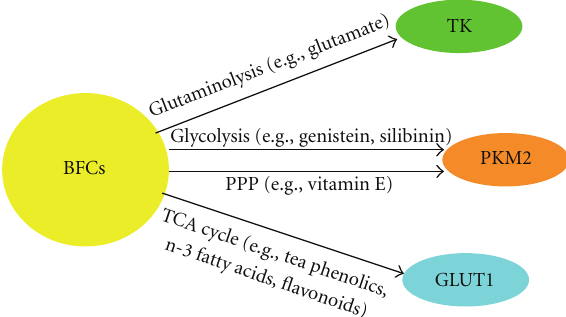
Figure 1: Potential metabonomic targets for bioactive food com- ponents during glucose metabolism in cancer cells. Cancer cells metabolize glucose and glutamine more than normal cells to sup- port the de novo biosynthesis of nucleotides and energy required for the high rate of cell proliferation. Tumor-specific PKM2 determines the ratio of glucose metabolism between glycolysis and PPP, whereas GLUT1 and TK play critical roles in energy production in neoplastic cells via the TCA cycle and glutaminolysis, respectively. Each of these pathways is modulated by specific bioactive food components (see text). BFCs: bioactive food components; PKM2: pyruvate kinase M2 isoform; PPP: pentose phosphate pathway; TK: tyrosine kinase; GLUT1: glucose transporter 1; TCA: tricarboxylic